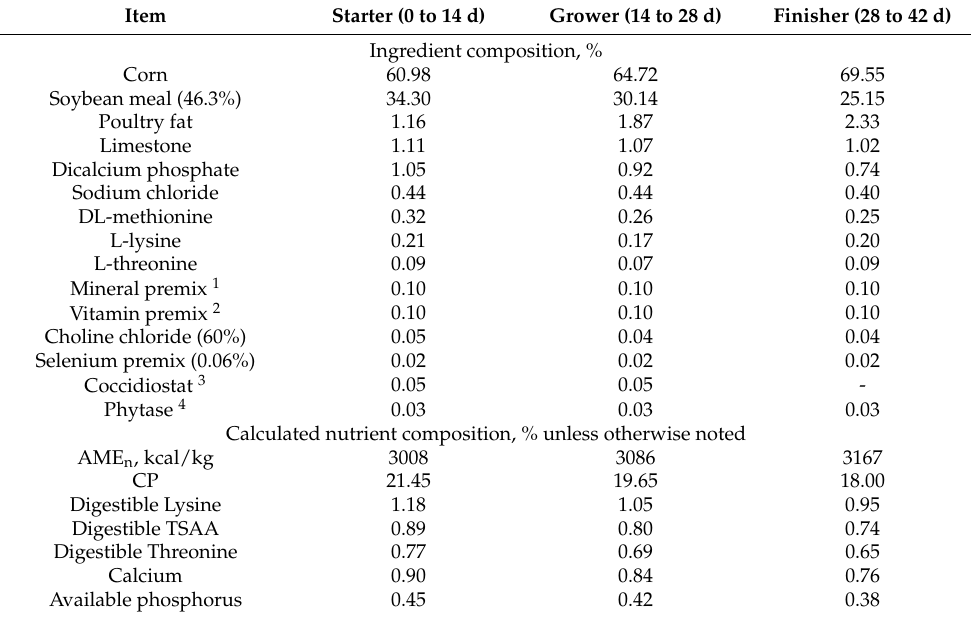
Table 1. Ingredient and calculated nutrient composition of common